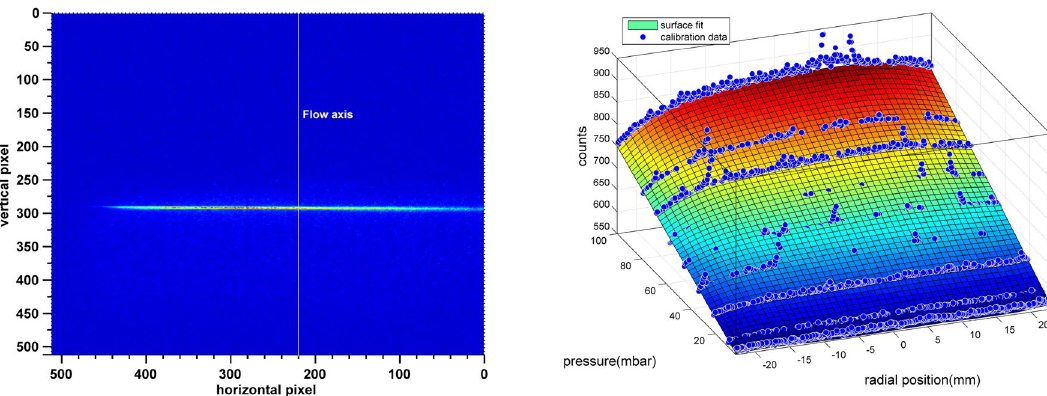
Figure 3. Left panel shows Rayleigh scattered image of the laser beam at background pressure of 100 mbar. Right panel shows the Pressure-intensity plots at different radial position. Geometric constant k is determined for different radial position by fitting a polynomial surface which is linear along the pressure axis and quadratic along the radial